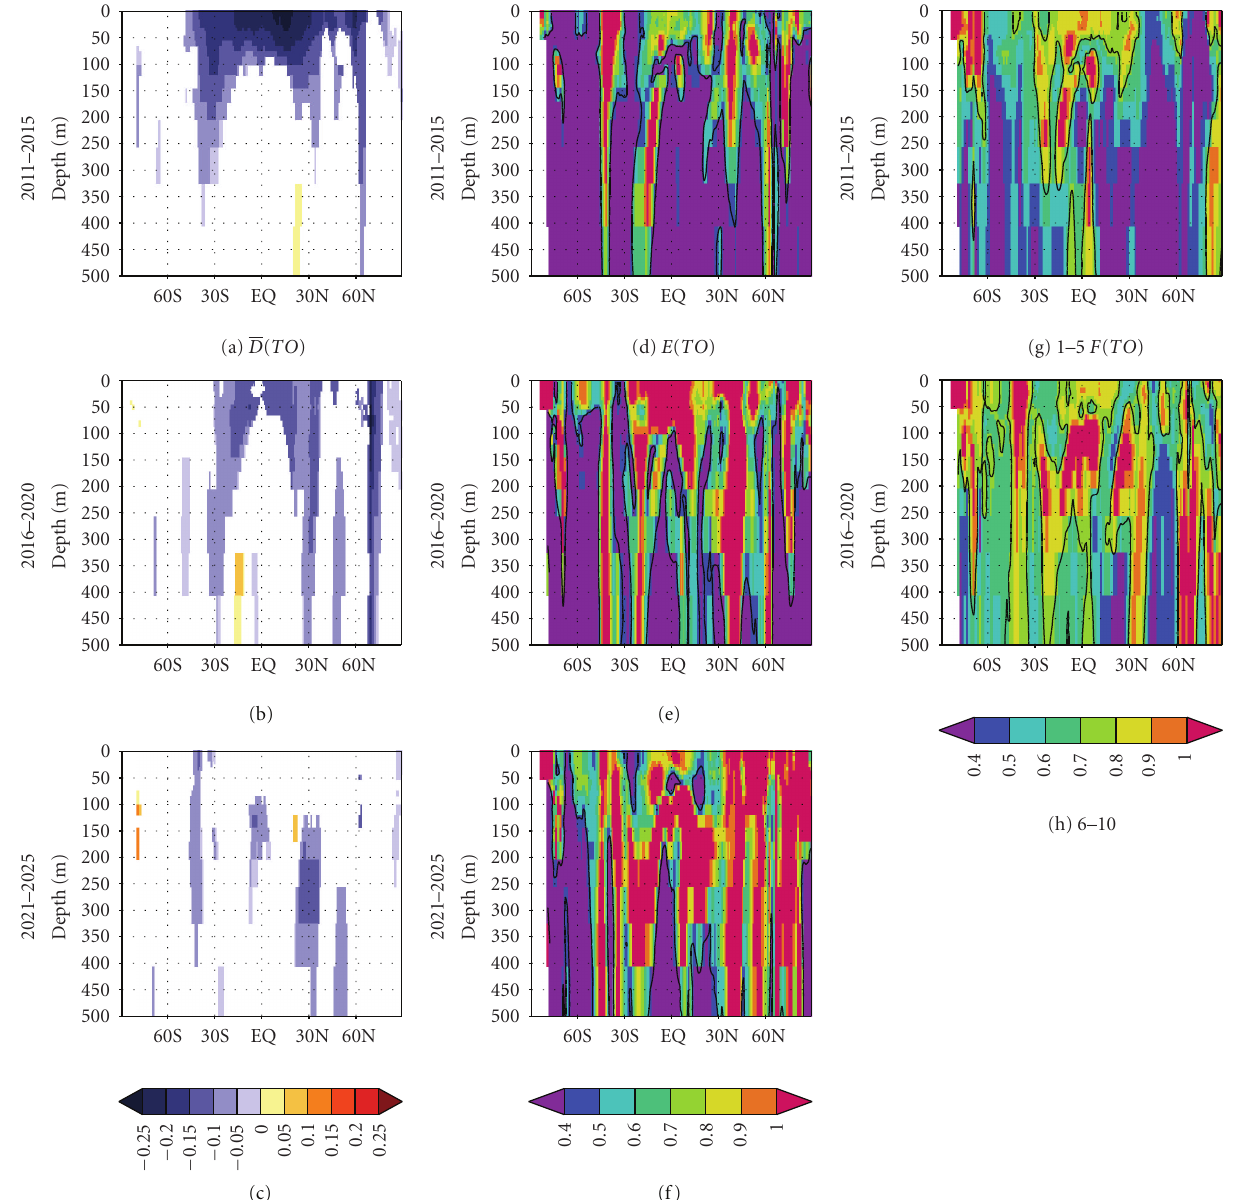
Figure 4: Changes in 5-yr averaged zonal mean TO. Left panels are the mean responses to the Pinatubo forcing, D ( TO ), from the 2011–2015 period to the 2021–2025 period ( ◦ C). Shading shows only significant responses at the ± 10% levels of t -test. Middle and right panels indicate E ( TO ) and F ( TO ), respectively. Contours denote significant small E ( TO ) and F ( TO ) at the 10% level of F